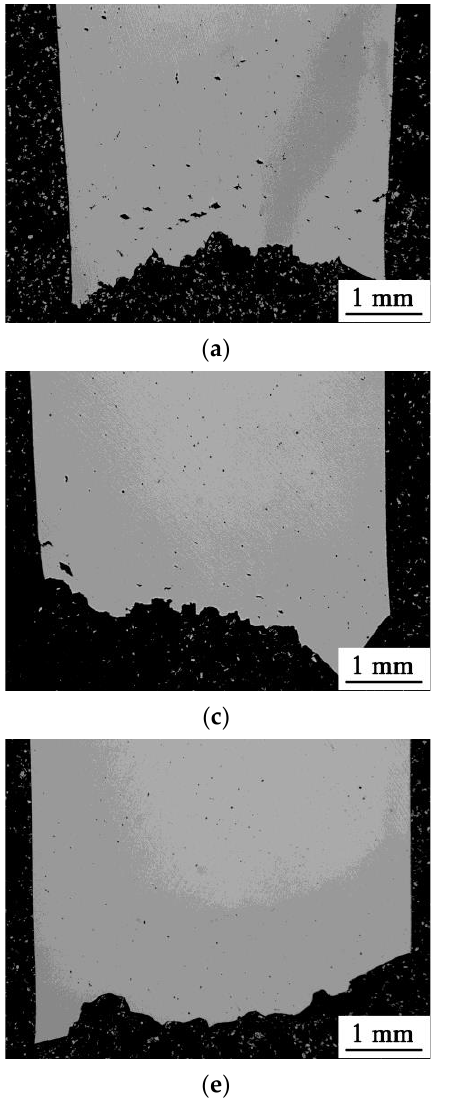
Figure 7. Morphologies of the longitudinal section and microstructures near the fracture surface of tensile-ruptured DD9 alloy with LABs at 1100°C: ( a , b ),3.7°;( c , d ), 6.0°; ( e , f ), 11.4°.